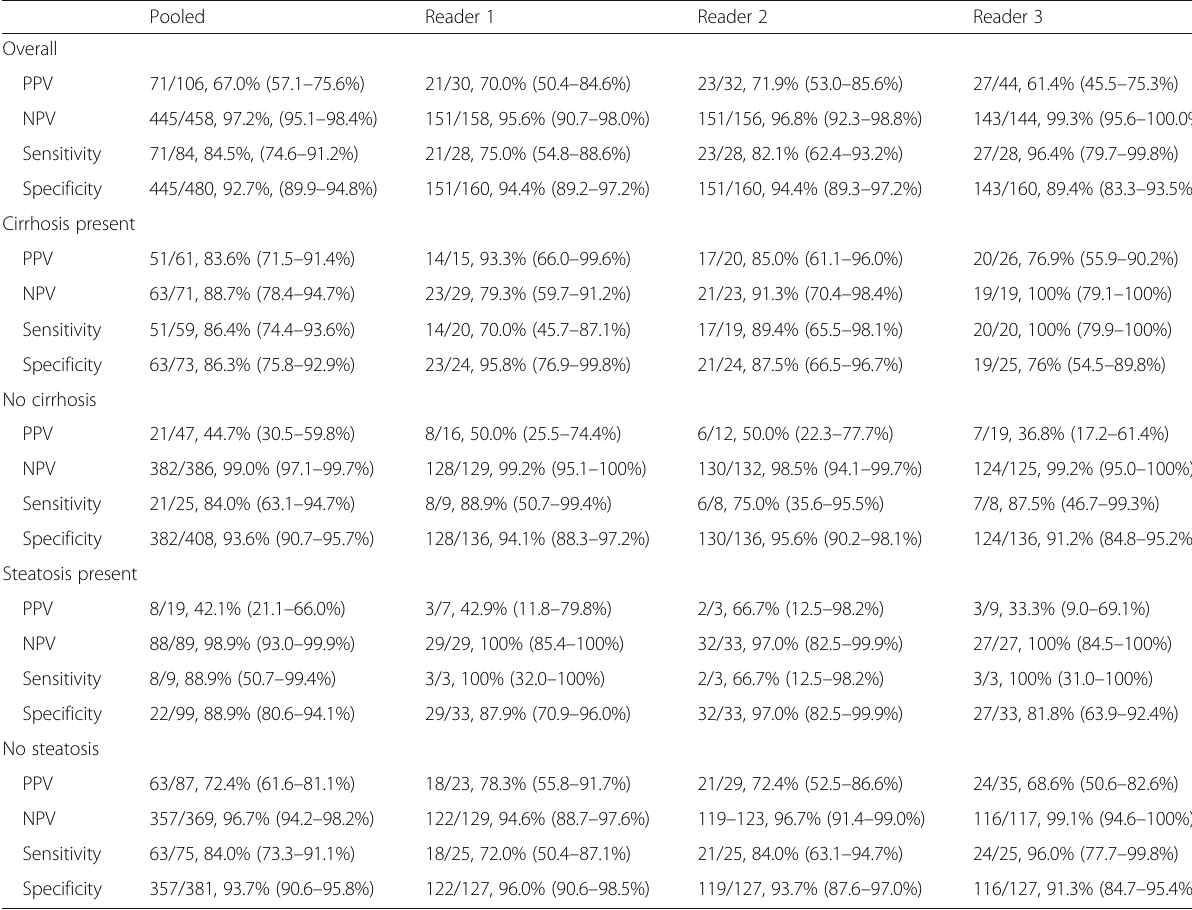
Table 3 Per-patient sensitivity, specificity, PPV, and NPV for aNC-MRI for LI-RADS 4, 5, and M categories at full protocol including contrast-enhanced